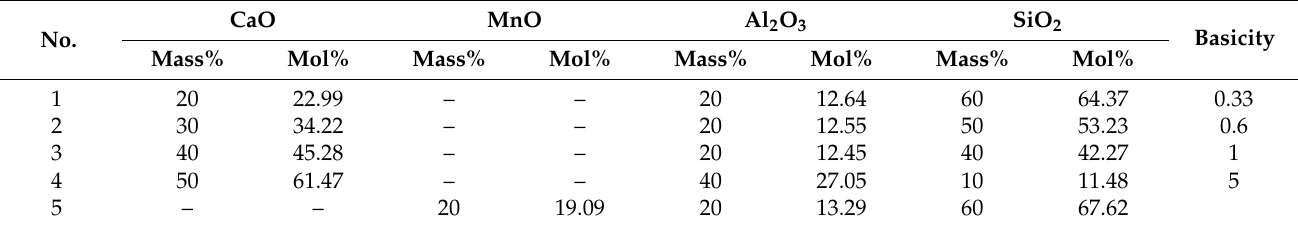
Table 1. The chemical compositions of the samples investigated in the present